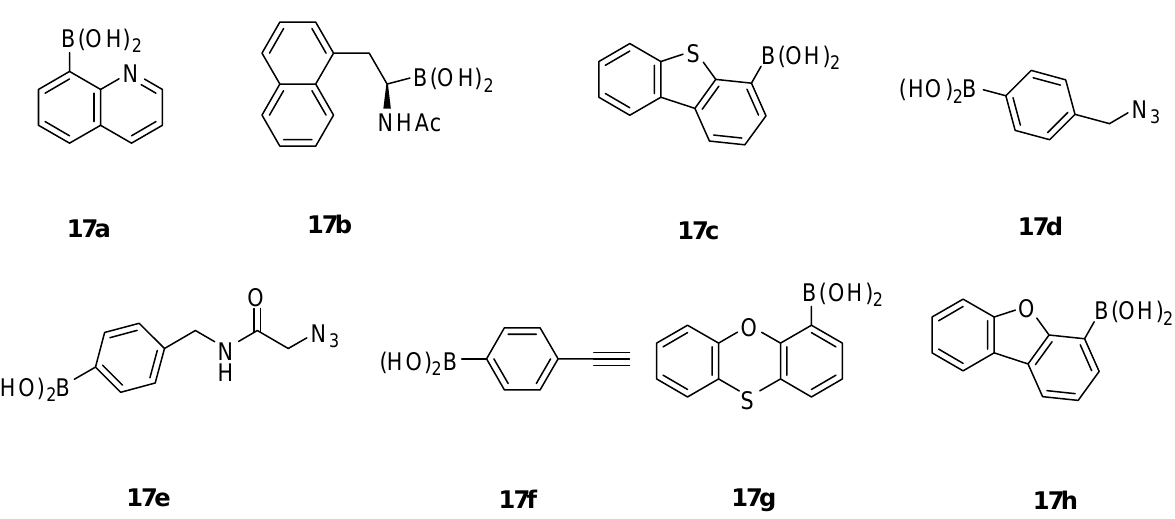
Figure 2. Structures of compounds 17a ~ 17h for the stability